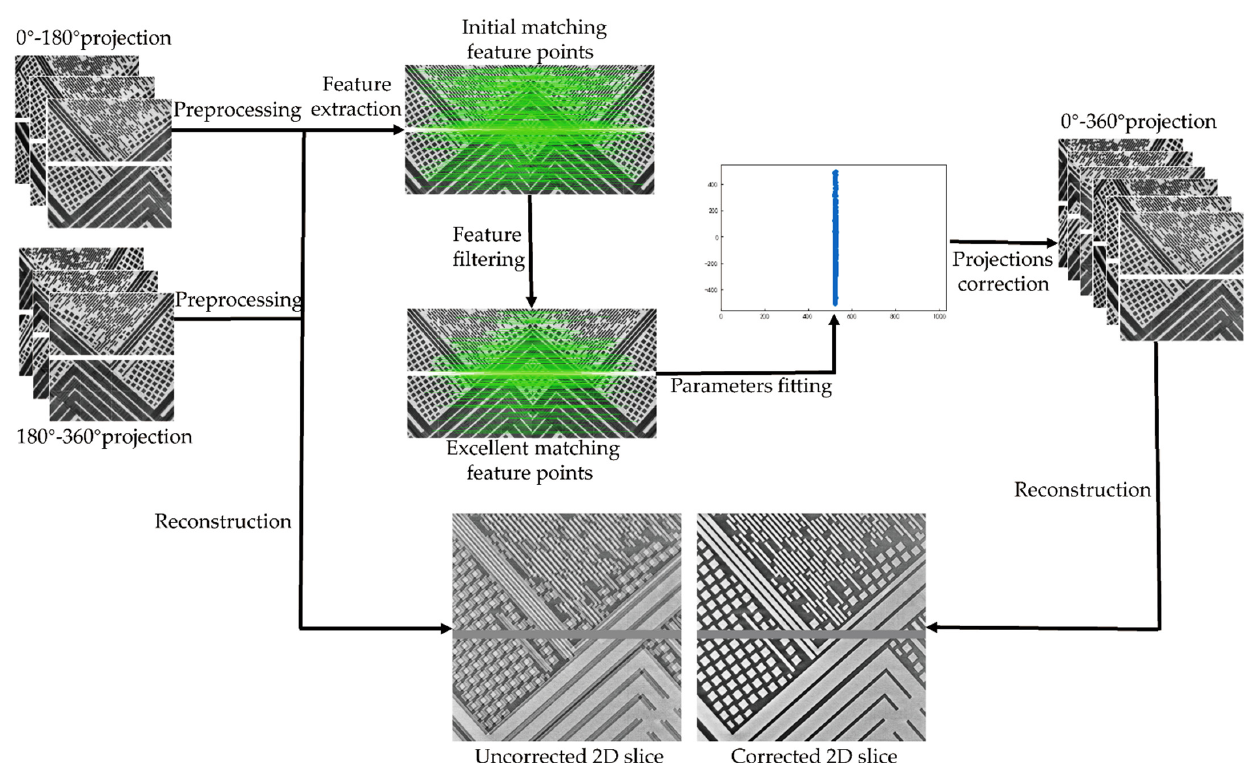
Figure 2. The parameter calibration flow of the proposed method.